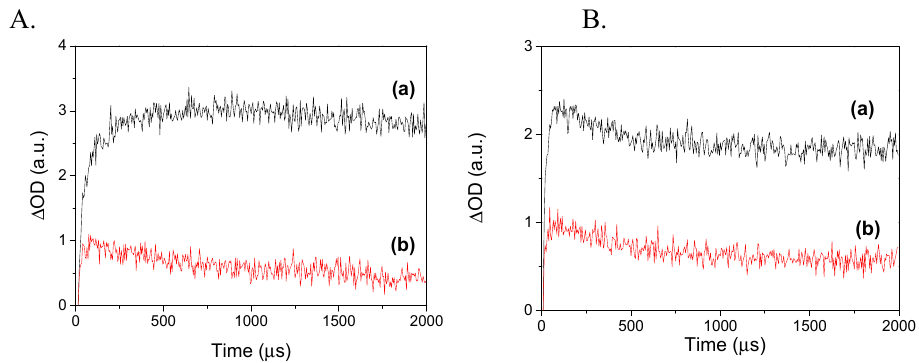
Figure 8. ( A ) Signal decay monitored at 640 nm before ( a ) and after water vapor exposure ( b ). ( B ) Signal decay monitored at 850 nm before ( a ) and after water vapor exposure ( b ).